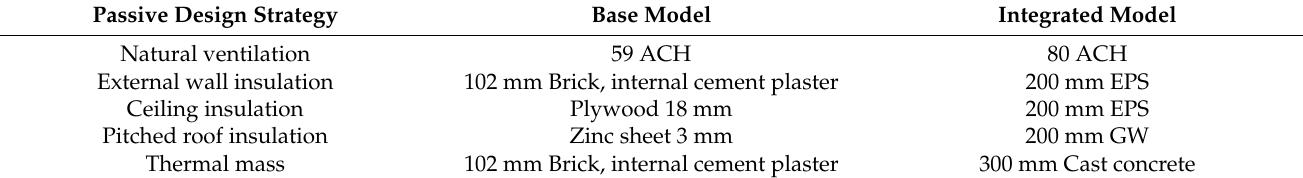
Table 12. Structure of the base model and the integrated model.